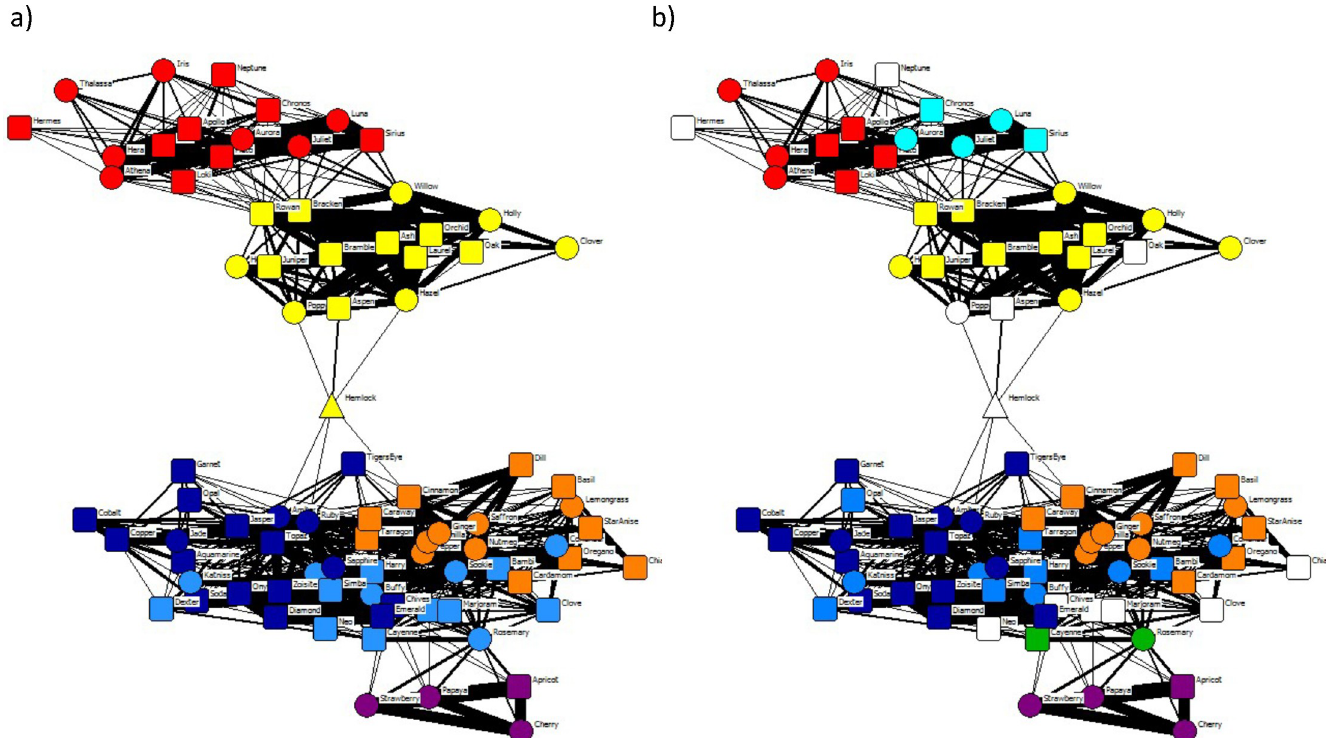
Fig 3. Space use network with (a) colours representing communities based on daily space use overlap and (b) colours representing communities based on spatiotemporal associations, for comparison. Line thickness is proportional to the simple ratio index (SRI) based on the number of days when dyads visited the same patches. Node shapes represent males ( ■ ), females ( ● ) and unknown sex ( ▲